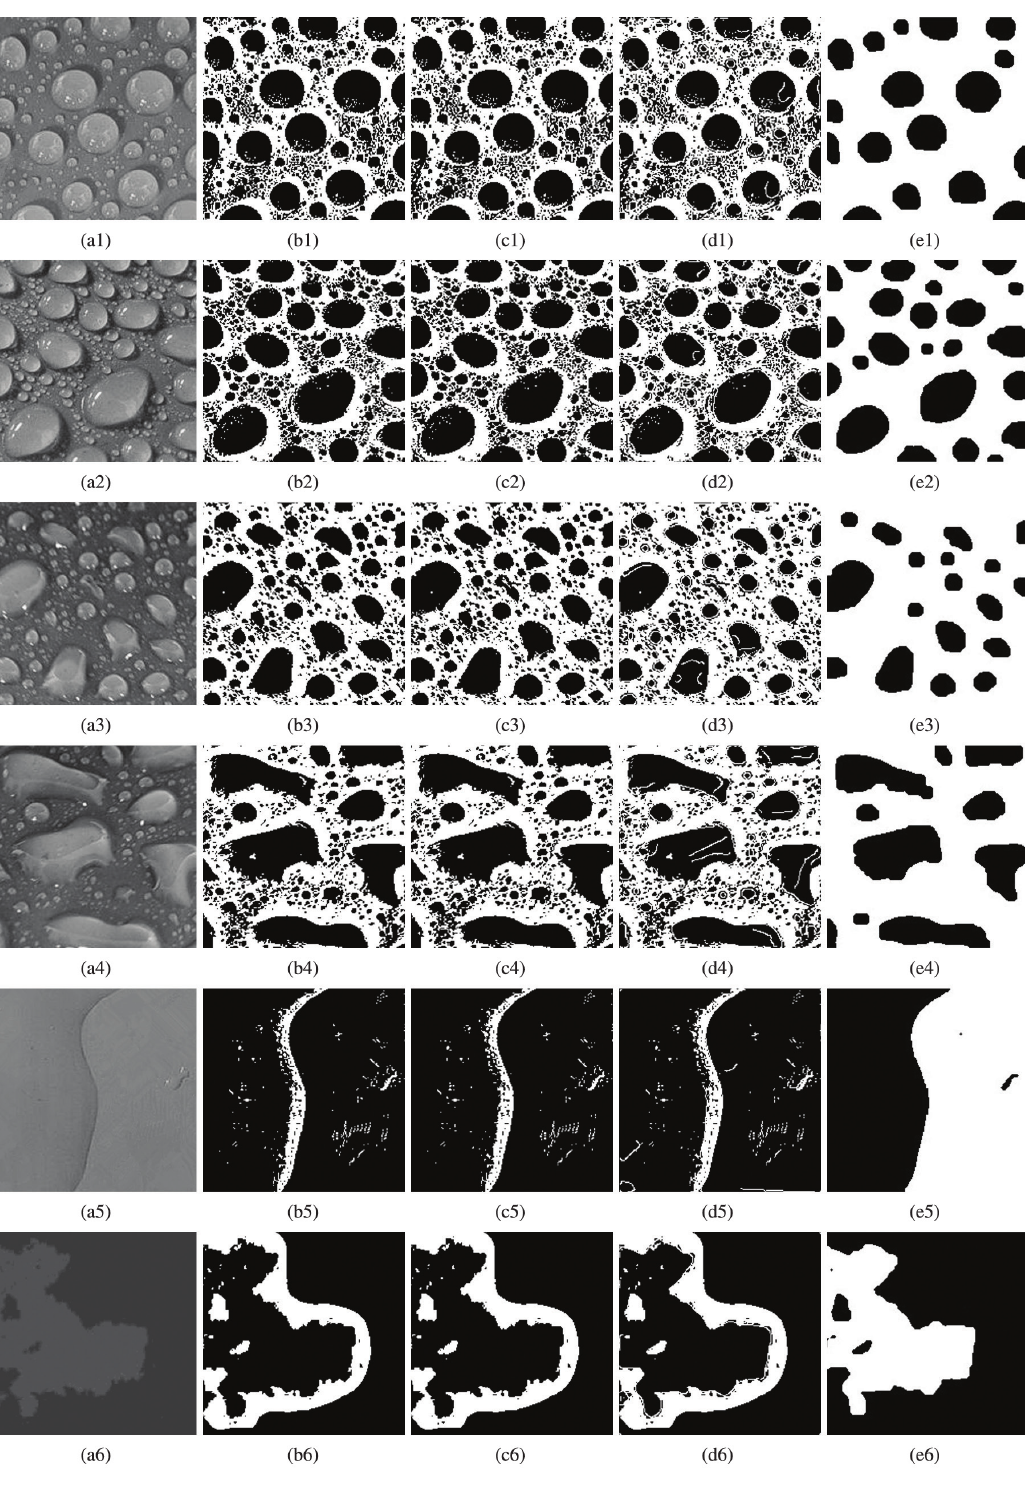
Figure 2. Image processing results. a1)-a6) represent the original images from HC1-HC6, b1)-b6) represent the results of the adaptive threshold method from HC1-HC6, c1)-c6) represent the results of the COATS method from HC1-HC6, d1)-d6) represent the final results of mathematical morphology from HC1-HC6. Average elapsed time is 0.922 seconds on PC and 2.3 seconds on